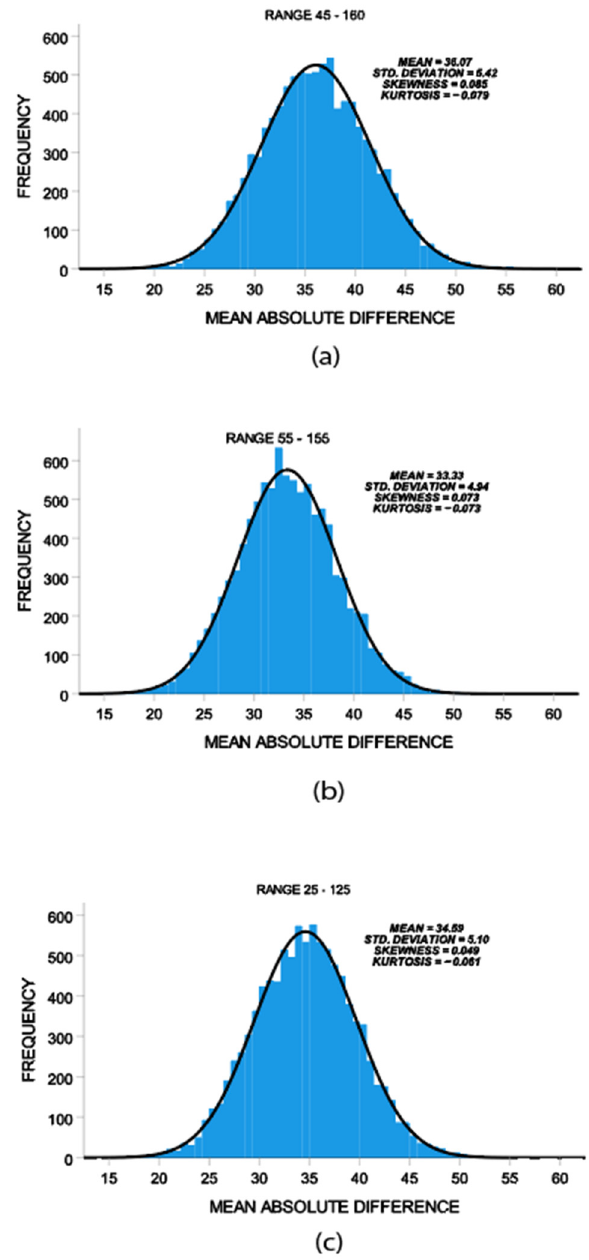
Figure 4. Principal results from three simulations of responses by a responder who guesses at random with equal probability from a given range of movement. Panels ( a – c ) show distributions for different response ranges. Panels ( b , c ) illustrate 100 ◦ range simulations for left and right wrists, respectively, demonstrating very similar distribution statistics.